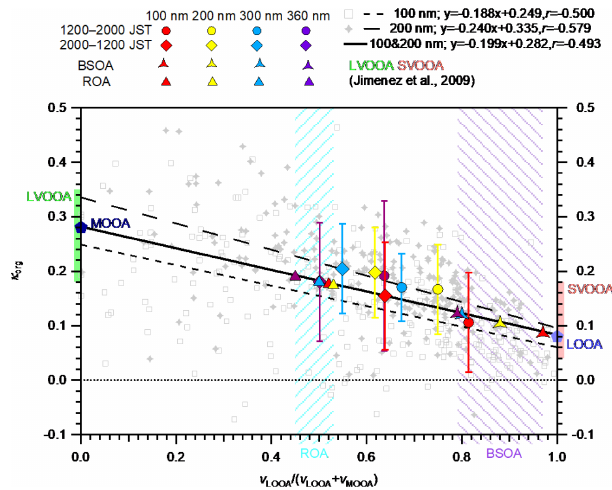
Figure 5. κ org versus v LOOA / ( v LOOA + v MOOA ) for particles with d dry of 100nm (gray open squares) and 200nm (gray cross mark- ers) over the entire study period. The time resolution of individual data is 2h. Only data with ε org >0.40 are considered. The short- dashed, long-dashed, and solid lines are the regression lines for par- ticles with d dry of 100, 200nm, and the sum of the particles with the two sizes, respectively. The κ values of LOOA and MOOA derived from the regression lines (Sect. 4.2.1) are indicated by the light and dark blue pentagons, respectively. The size-resolved mean κ org val- ues during 12:00–20:00 and 20:00–12:00JST are indicated as filled circles and diamond markers, respectively. The standard deviations of the mean κ org are indicated by the whiskers. The standard devi- ations of the mean v LOOA / ( v LOOA + v MOOA ) are presented in Ta- ble S6. The size-resolved κ values of BSOA and ROA are indicated by the three-pointed stars and triangles, respectively. The diameters of κ org , κ BSOA , and κ ROA are differentiated by colors. The ranges of κ for low-volatility oxygenated OA (LVOOA) and semivolatile oxygenated OA (SVOOA) from Jimenez et al. (2009) are superim- posed on the left and right axes, respectively. The shaded areas rep- resent the estimated ranges of v LOOA / ( v LOOA + v MOOA ) for ROA (left slash pattern) and BSOA (right slash pattern) of 100–360nm